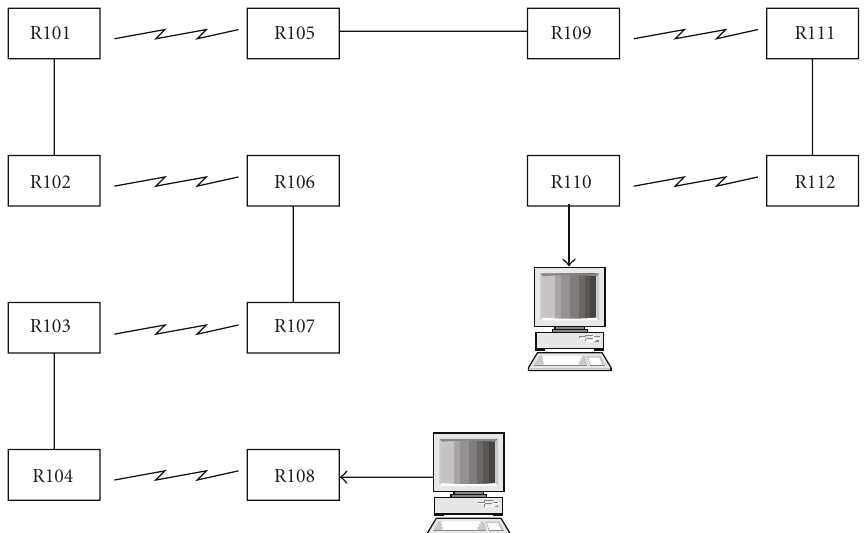
Figure 20: Multihop scenario.